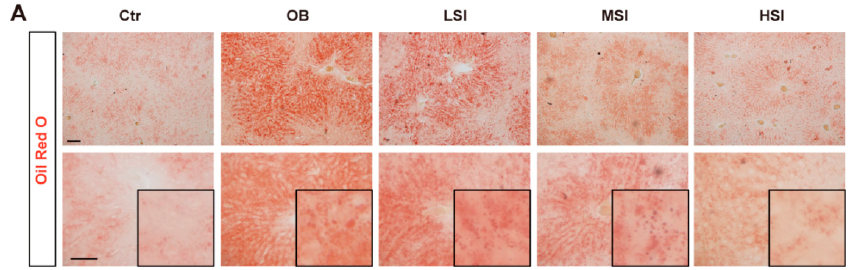
Figure 2. Cont. Figure 2.